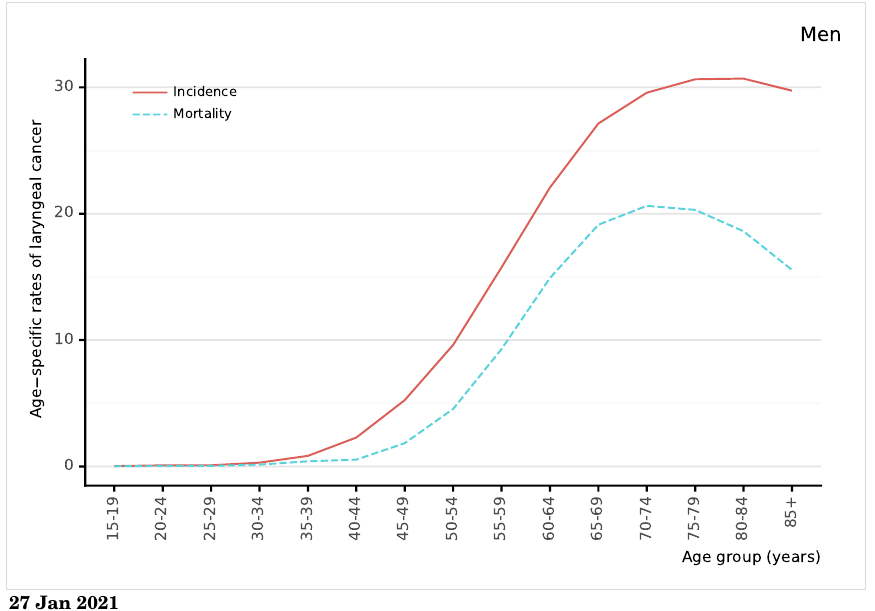
Figure 52: Comparison of age-specific laryngeal cancer incidence and mortality rates among men in India (estimates for 2020)